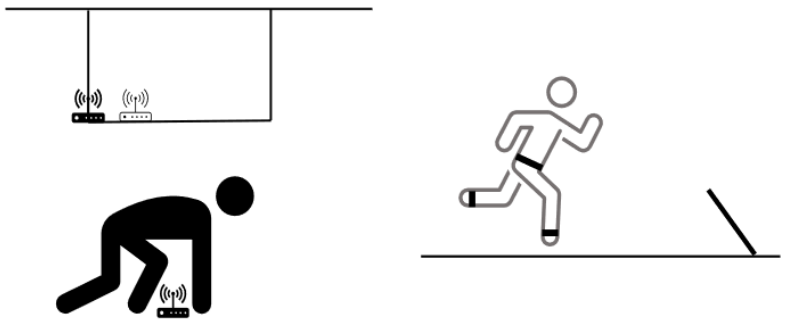
Figure 2. Outline of the experimental set-up. Left, static measurements and possible interactions. Upper part, a transponder (black) was placed at a known position on the field. The system’s reported position was recorded and compared with the true position. A possible influence of a nearby transponder (white) was also recorded. Lower part, possible influence by a human body was recorded separately. Right part, dynamic measurements. A person walked or ran to a line at known position (dashed), and the system’s reported path was compared with the true position. In further experiments, the person wore transponders around the ankle, in addition to one around the waist (black bars). The reported movements were compared with those expected.